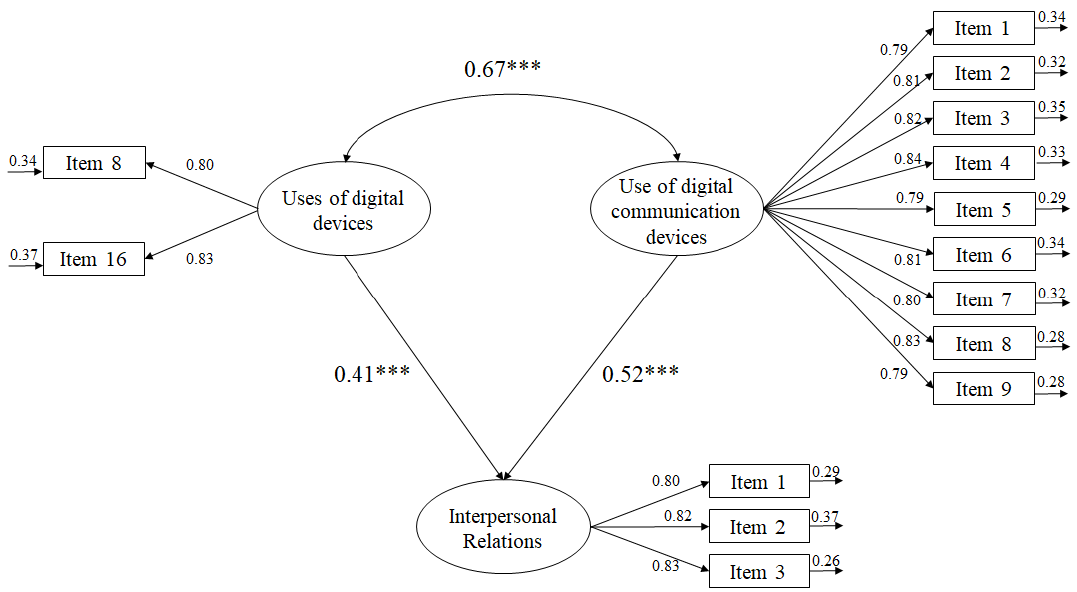
Figure 1. Relationships between the study variables through an SEM. *** p < 0.001. Table 2. Preliminary analysis.